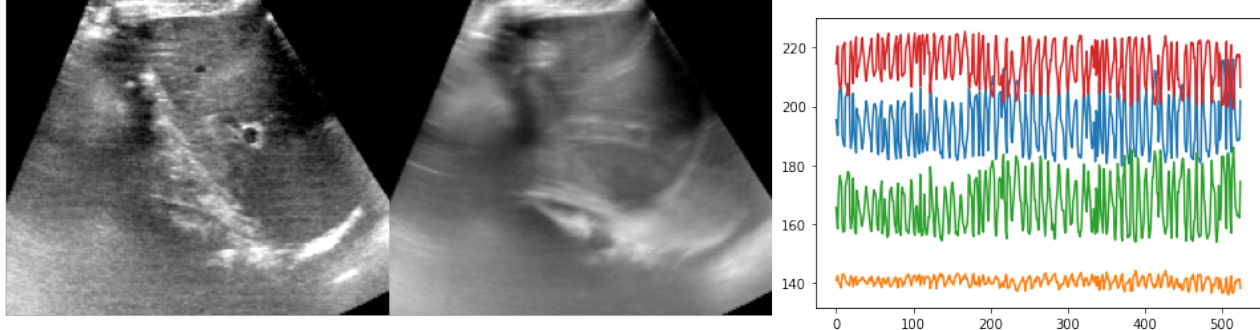
Figure 4. Example of reference frame and temporal average across one sequence from the ETHZ dataset, along with a plot of the observed motion, based on expert annotations (xy-coordinates for two landmarks) . The temporal average, which showed substantial blurring of anatomies over time, as well as the large and rapid xy-coordinate changes in the annotations highlighted the difficulty of the registration